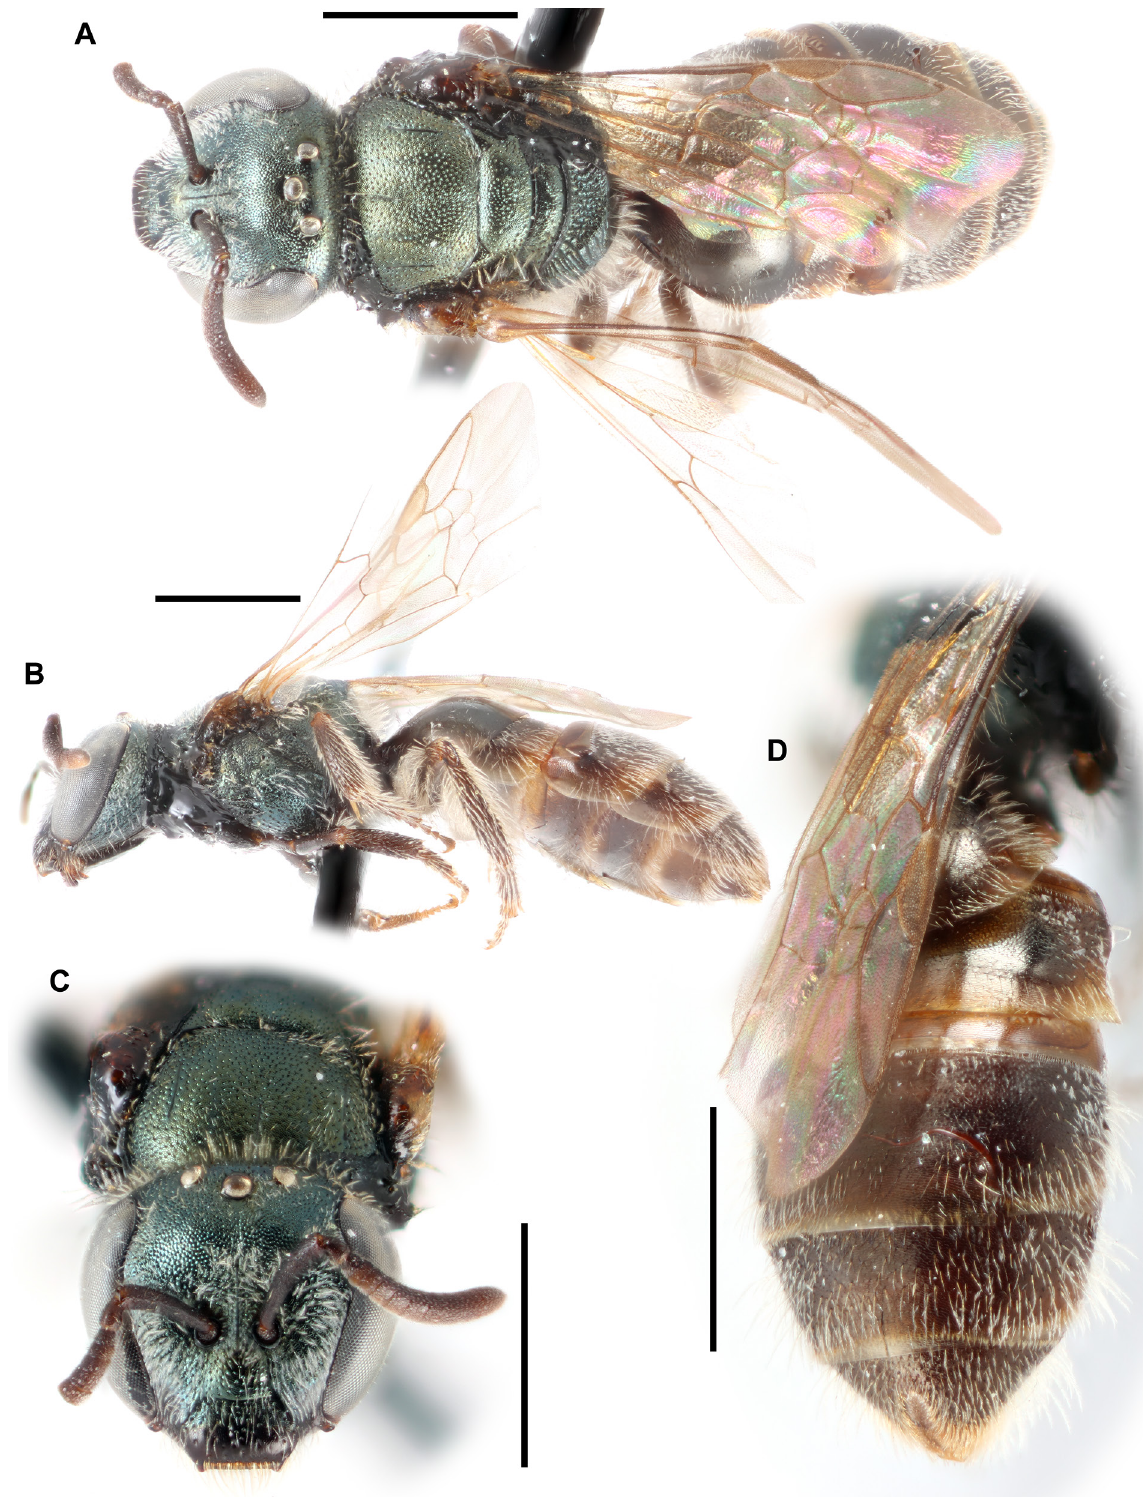
Fig. 39. Lasioglossum ( D .) lepidii (Graenicher, 1927), ♀ (PCYU). A . Dorsal habitus. B . Lateral habitus. C . Face. D . Metasoma. Scale bars = 1